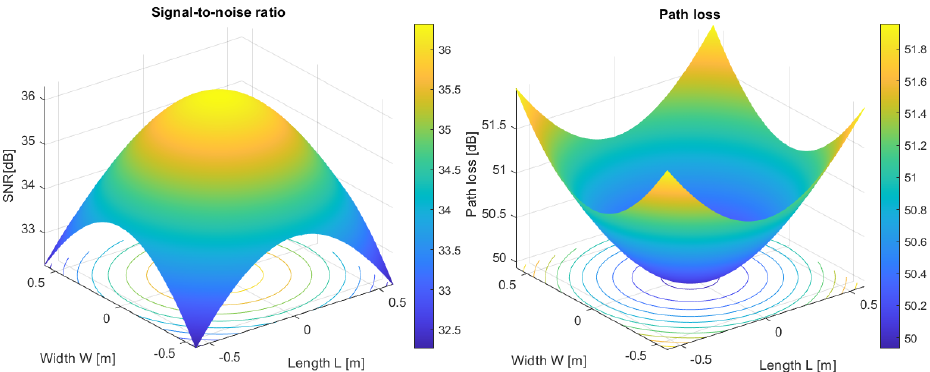
Figure 17. Signal-to-noise ratio (SNR) distribution in dB ( left ); Path loss distribution in dB ( right ).